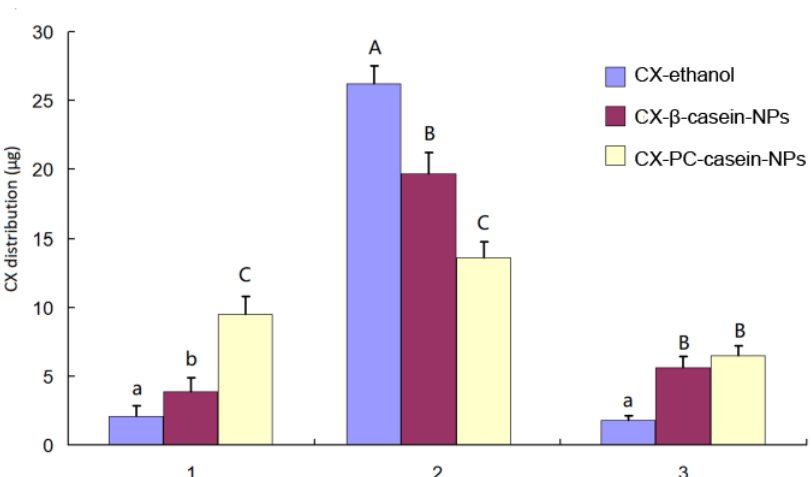
Figure 4. The CX distribution in the intracells (1) as crystallization, in the extracells (2), and in the culture medium (3) after the 24 h culture when 30 µ g CX was added into each well containing 1 mL of the culture medium. Di ff erent lowercase letters over the bars in each group indicate significant di ff erences at P < 0.05, and a lowercase letter and a di ff erent capital letter, or di ff erent capital letters, indicate significant di ff erence at P < 0.01.